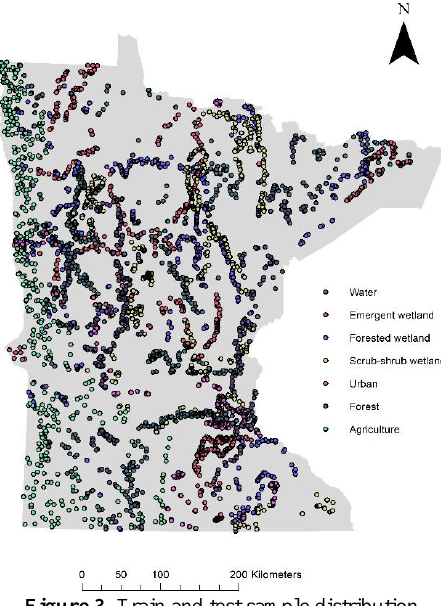
Figure 3. Train and test sample distribution